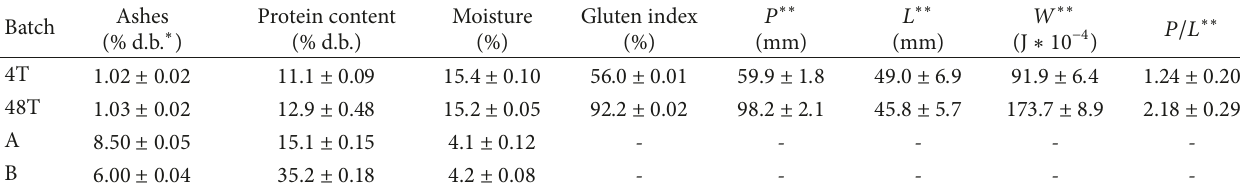
∗ Dry basis. ∗∗ Alveograph parameters at constant hydration: 𝑃 , maximum overpressure; 𝐿 , index of swelling; 𝑊 , deformation energy; 𝑃/𝐿 , configuration ratio. Data were expressed as mean ± standard